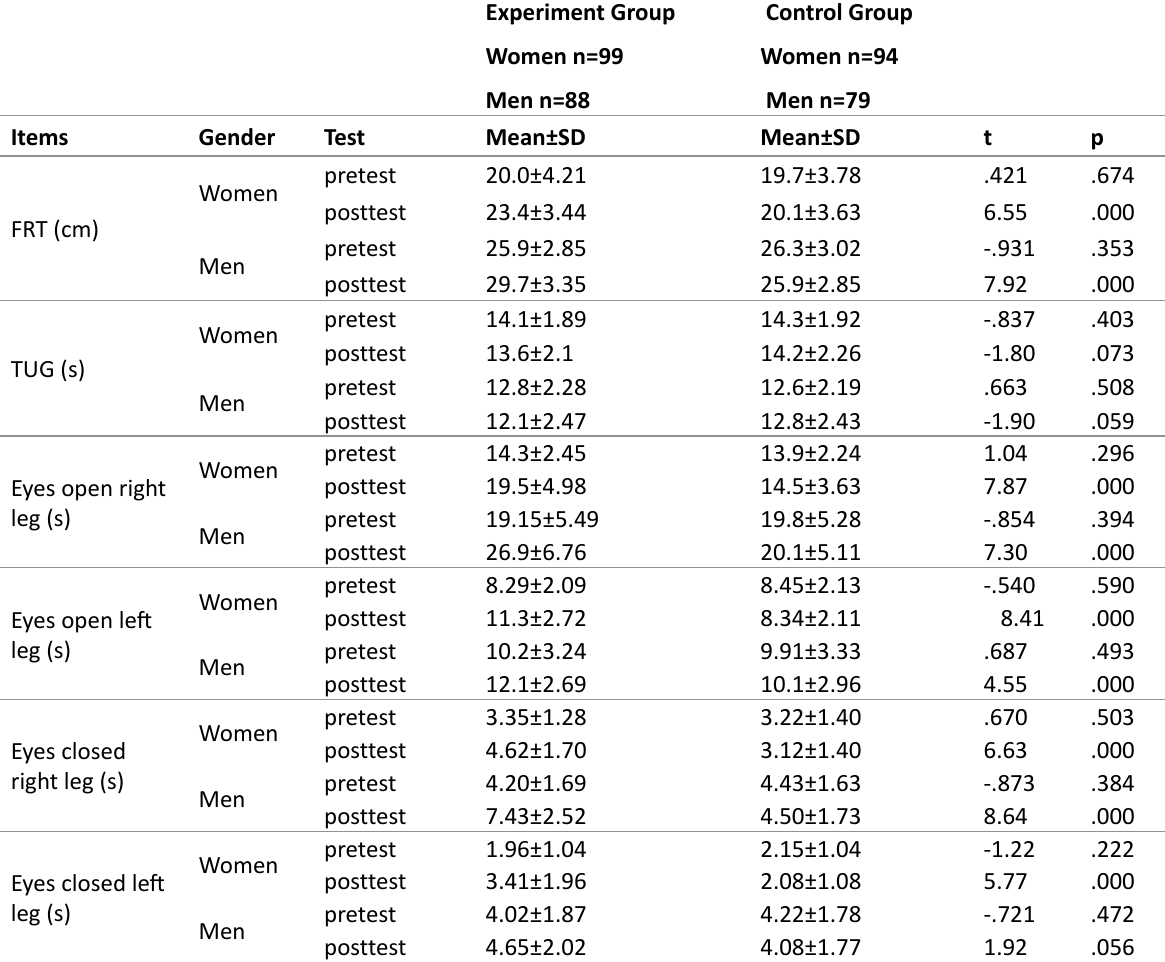
Table 3. Independent sample t-test results of pretest and posttest in experiment and control groups